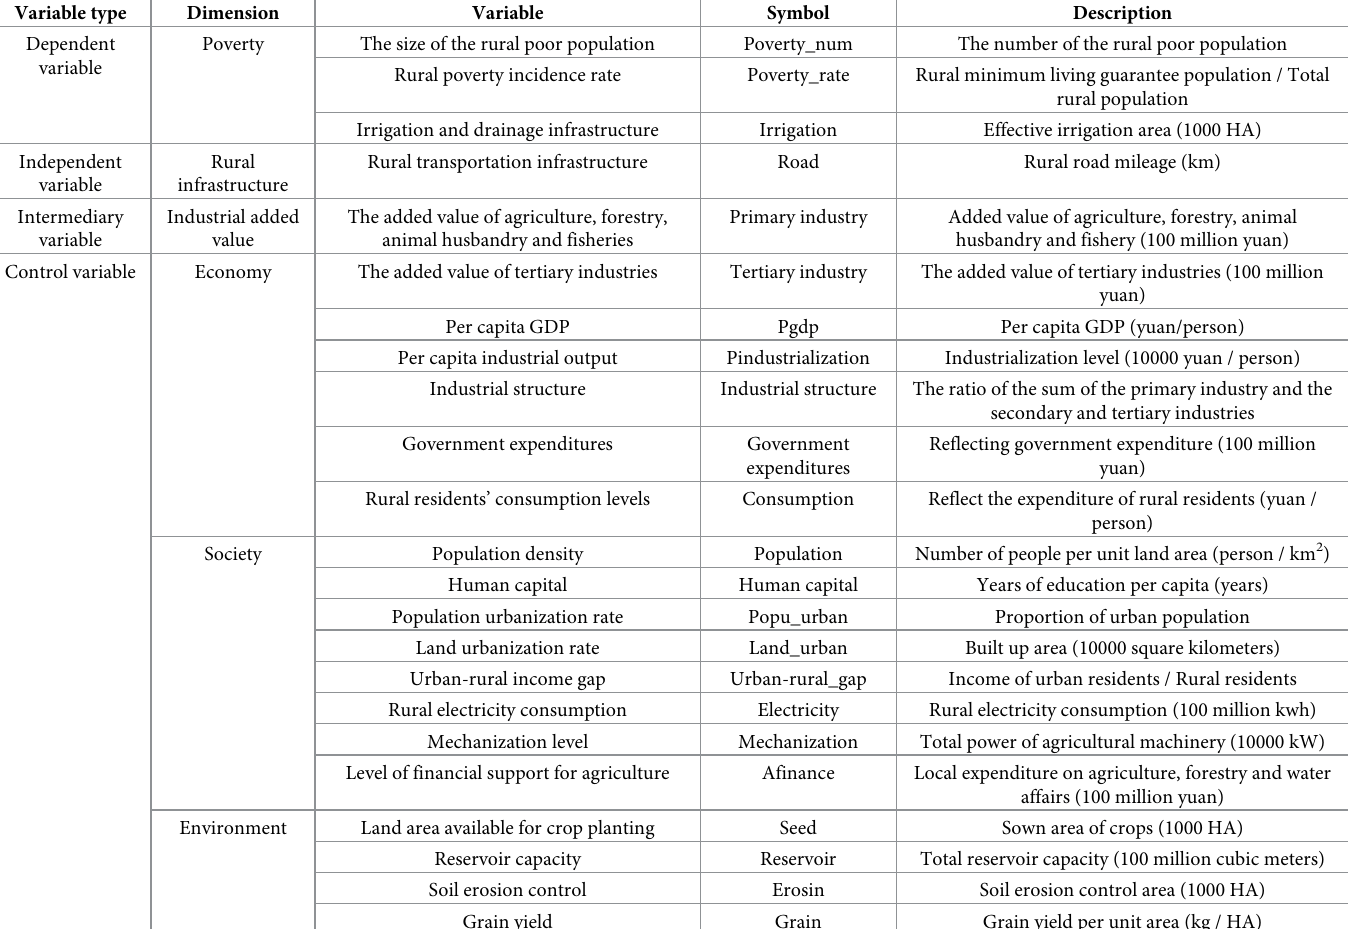
Table 1. Definition of the variables in the